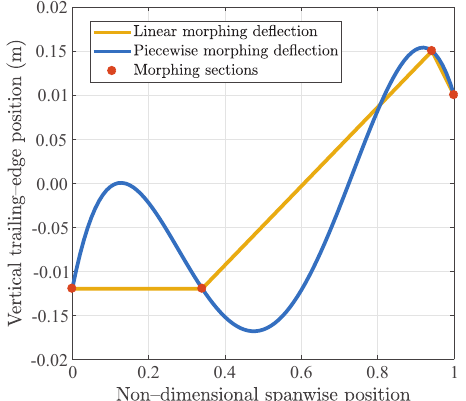
Figure 5. Vertical trailing-edge position